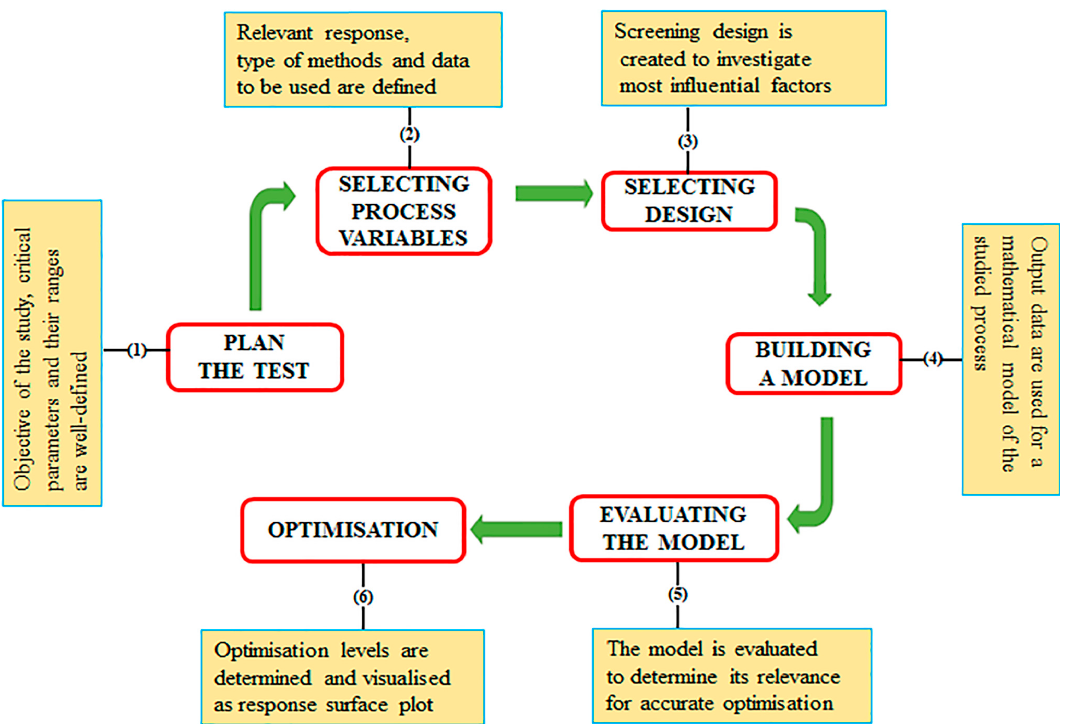
Figure 3. A typical DoE workflow for the optimisation of recombinant protein production. The figure describes the main steps involved in the experimental design when both screening and optimisation designs are used. (1) The objectives of the study are defined including the selection of factors, levels and responses. (2) Process variables and expected responses are identified; the process variable levels (for a 2 level study) are set as high (+1), low ( − 1), (on occasion a 0 point is included). (3) The experimental screening design is selected based on the objectives of the study and the number of factors involved. (4) A mathematical model is built with certain conditions to meet the desired objectives (e.g., measurement of all the desired responses, process stability and accurate approximation by polynomial models). (5) The response data are analysed and visualised using plots for ease of data interpretation. At this stage, a reduced number of factors (i.e., the most influential) are retained for the subsequent optimisation phase. (6) Further optimisation can be carried out (via an optimisation DoE design).